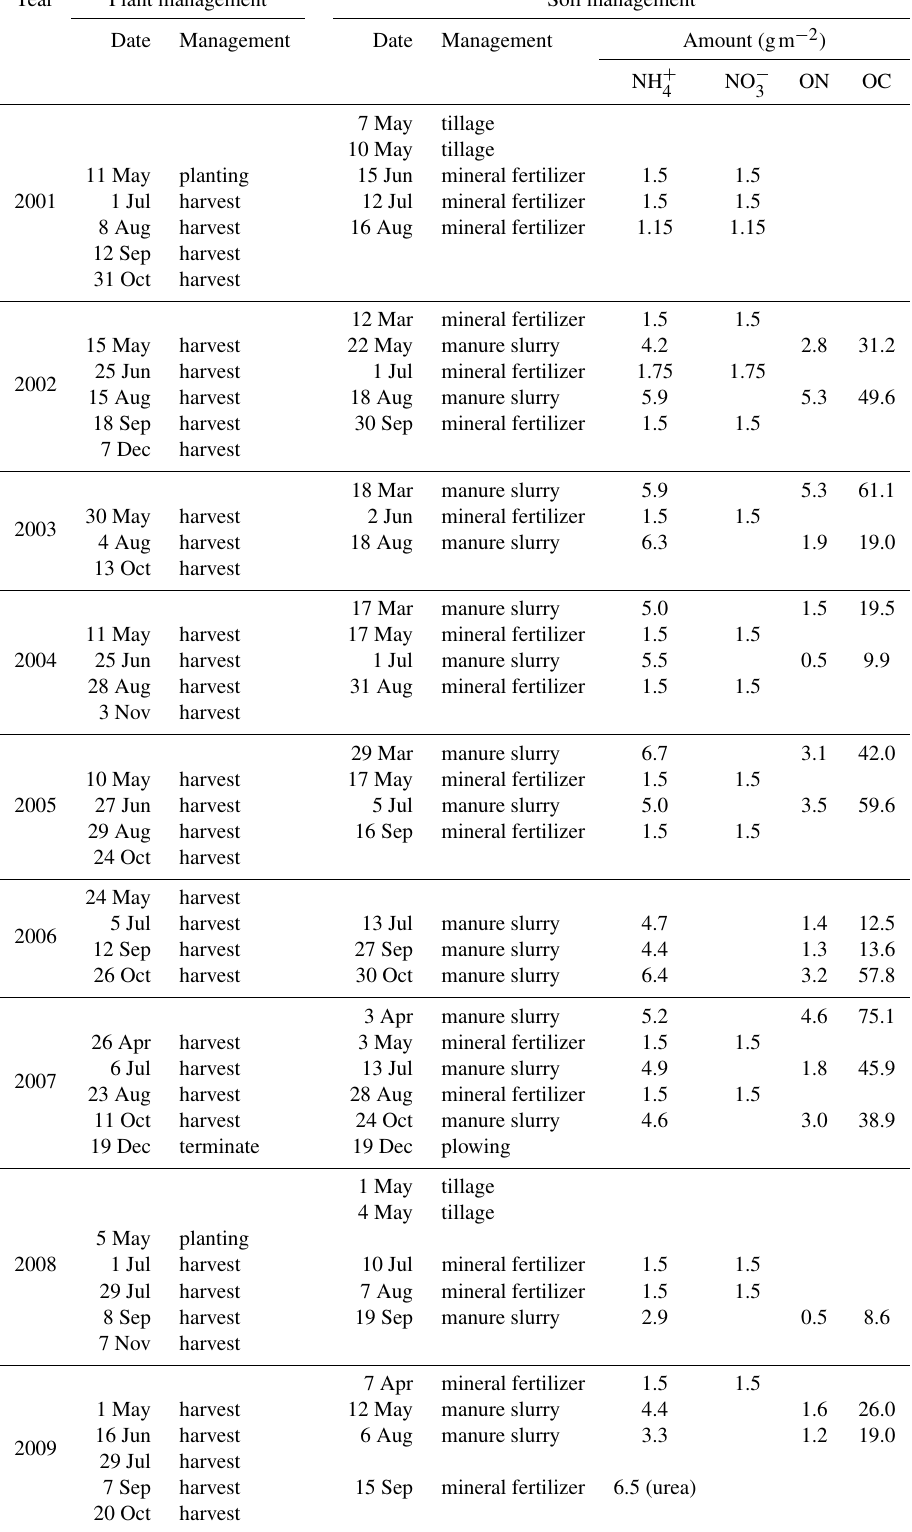
Table 2. Plant and soil management operations at the Oensingen intensively managed grassland from 2001 to